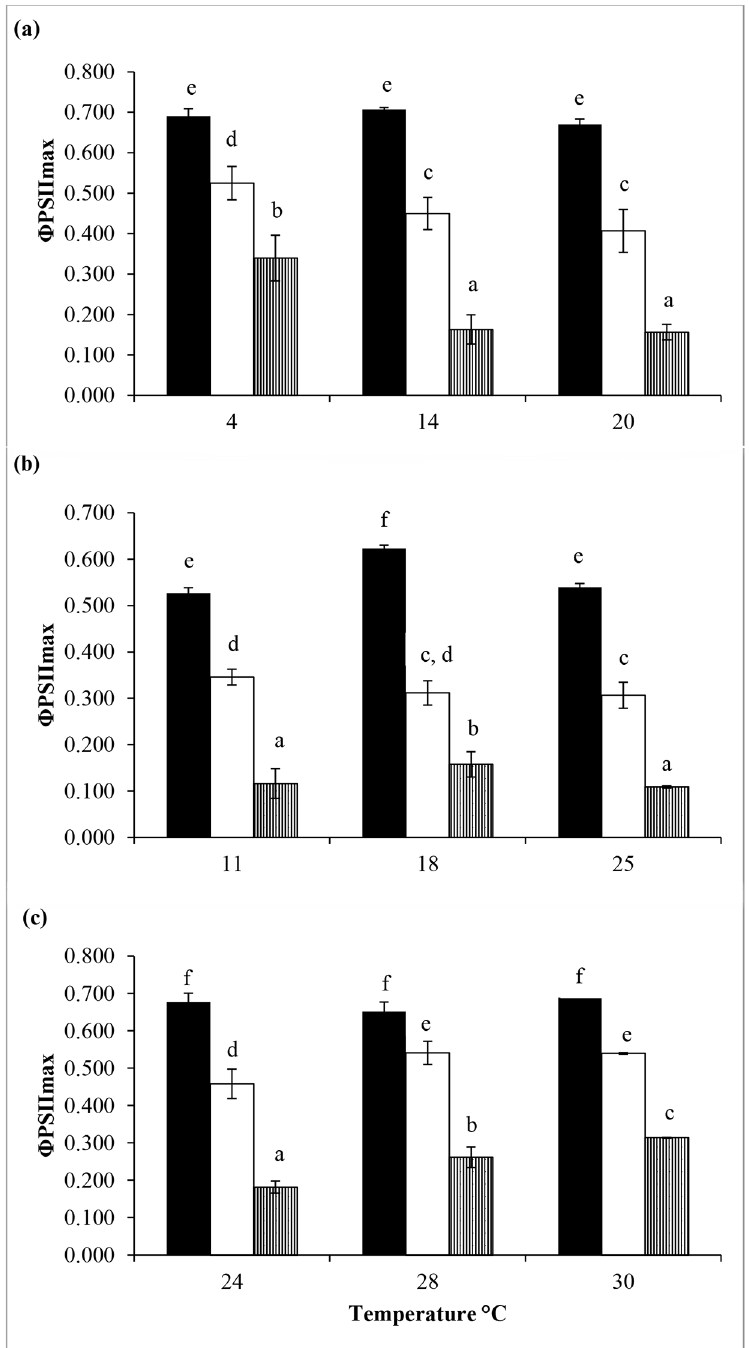
Fig 1. Effect of temperature and UVR on the maximum quantum yield of fluorescence ( Φ PSII max ) of (a) polar, (b) temperate and (c) tropical isolates of Chlorella . Vertical bars denote standard deviations from triplicate samples. Different letters indicate significant differences at p < 0.05. PAR (filled), PAR + UV-A (open), PAR + UV-A + UV-B